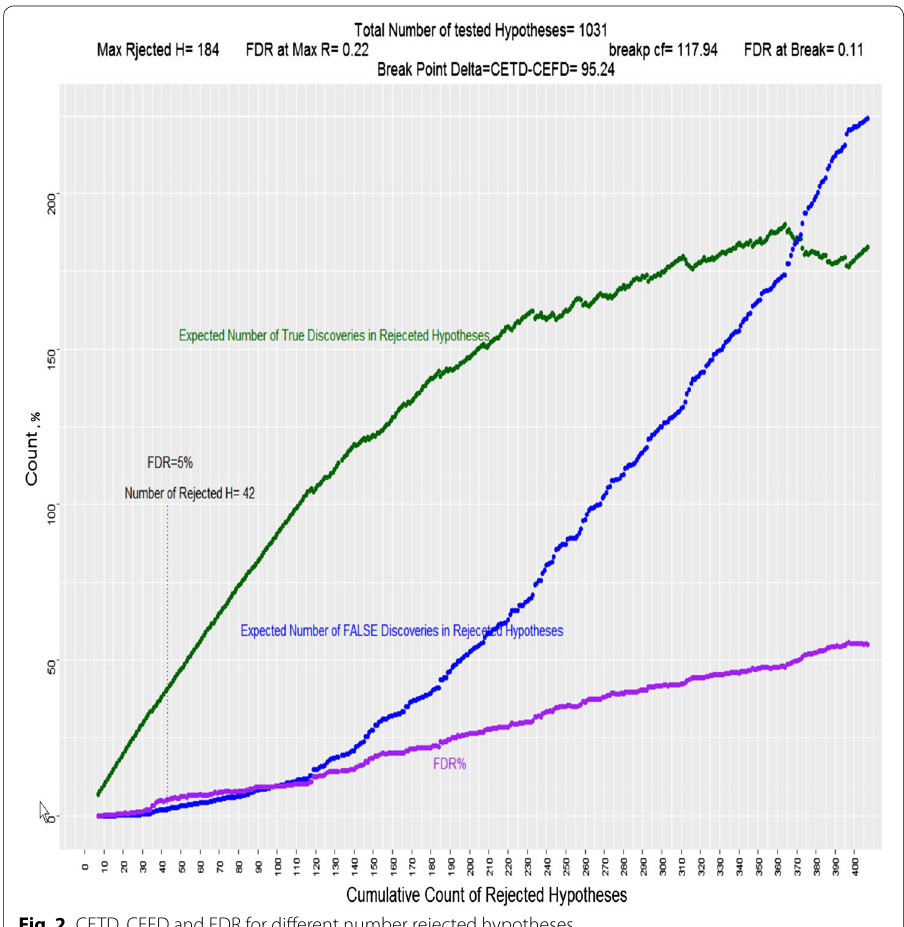
Fig. 2 CETD, CEFD and FDR for different number rejected